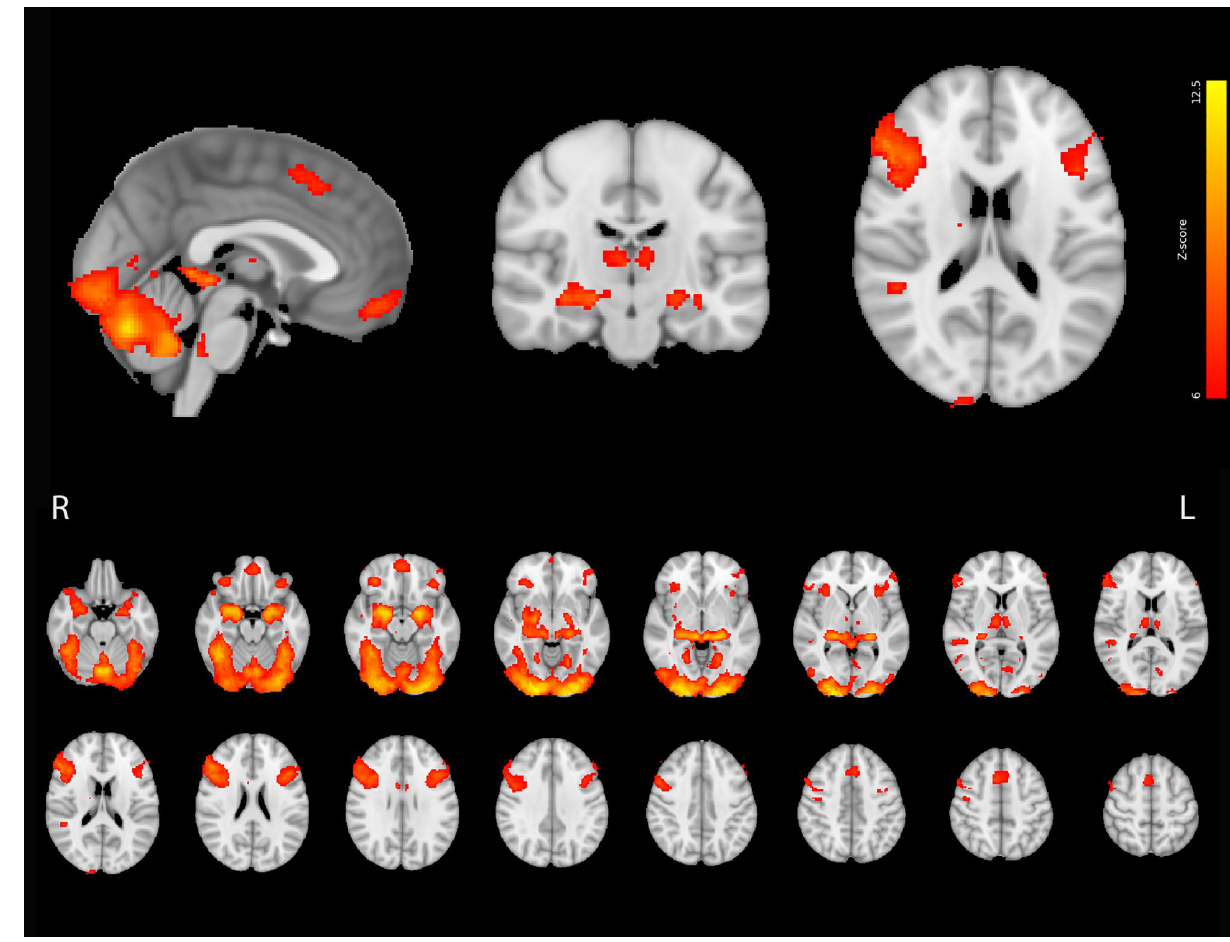
Figure 3. Mean task-dependent activations during the FERP. Image was thresholded using clusters determined by Z > 6 and a corrected cluster significance threshold of p = 0.05. Red–yellow colours indicate brain activation Z-scores during matching emotion tasks. Images are shown in radiological